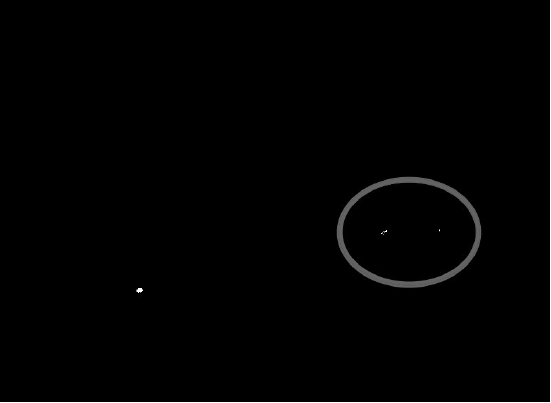
Figure 6. Occurrence of noise, can be filtered through size or